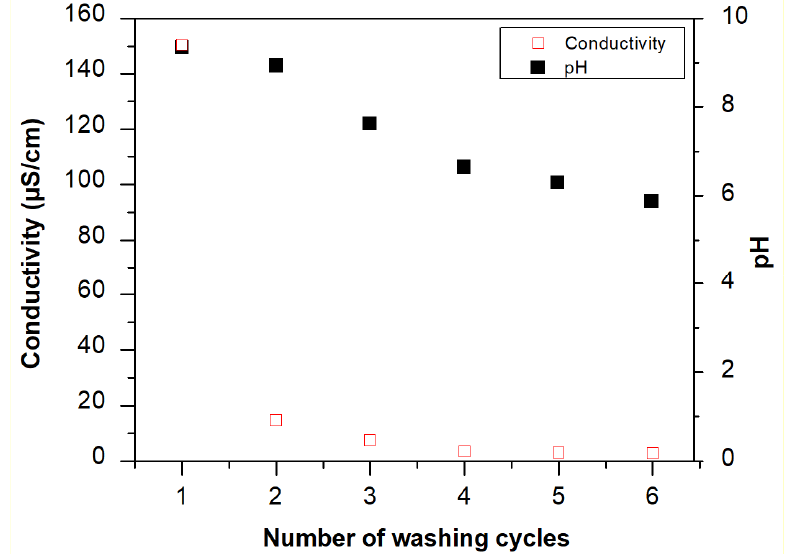
Figure 8. Evolution of conductivity and pH of the supernatant (washing solution) collected during the cs ‐ PES MF022 membrane washing process.